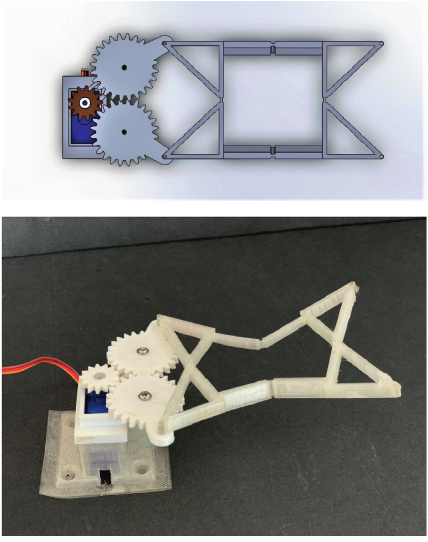
Figure 12: Assembled mechanism.